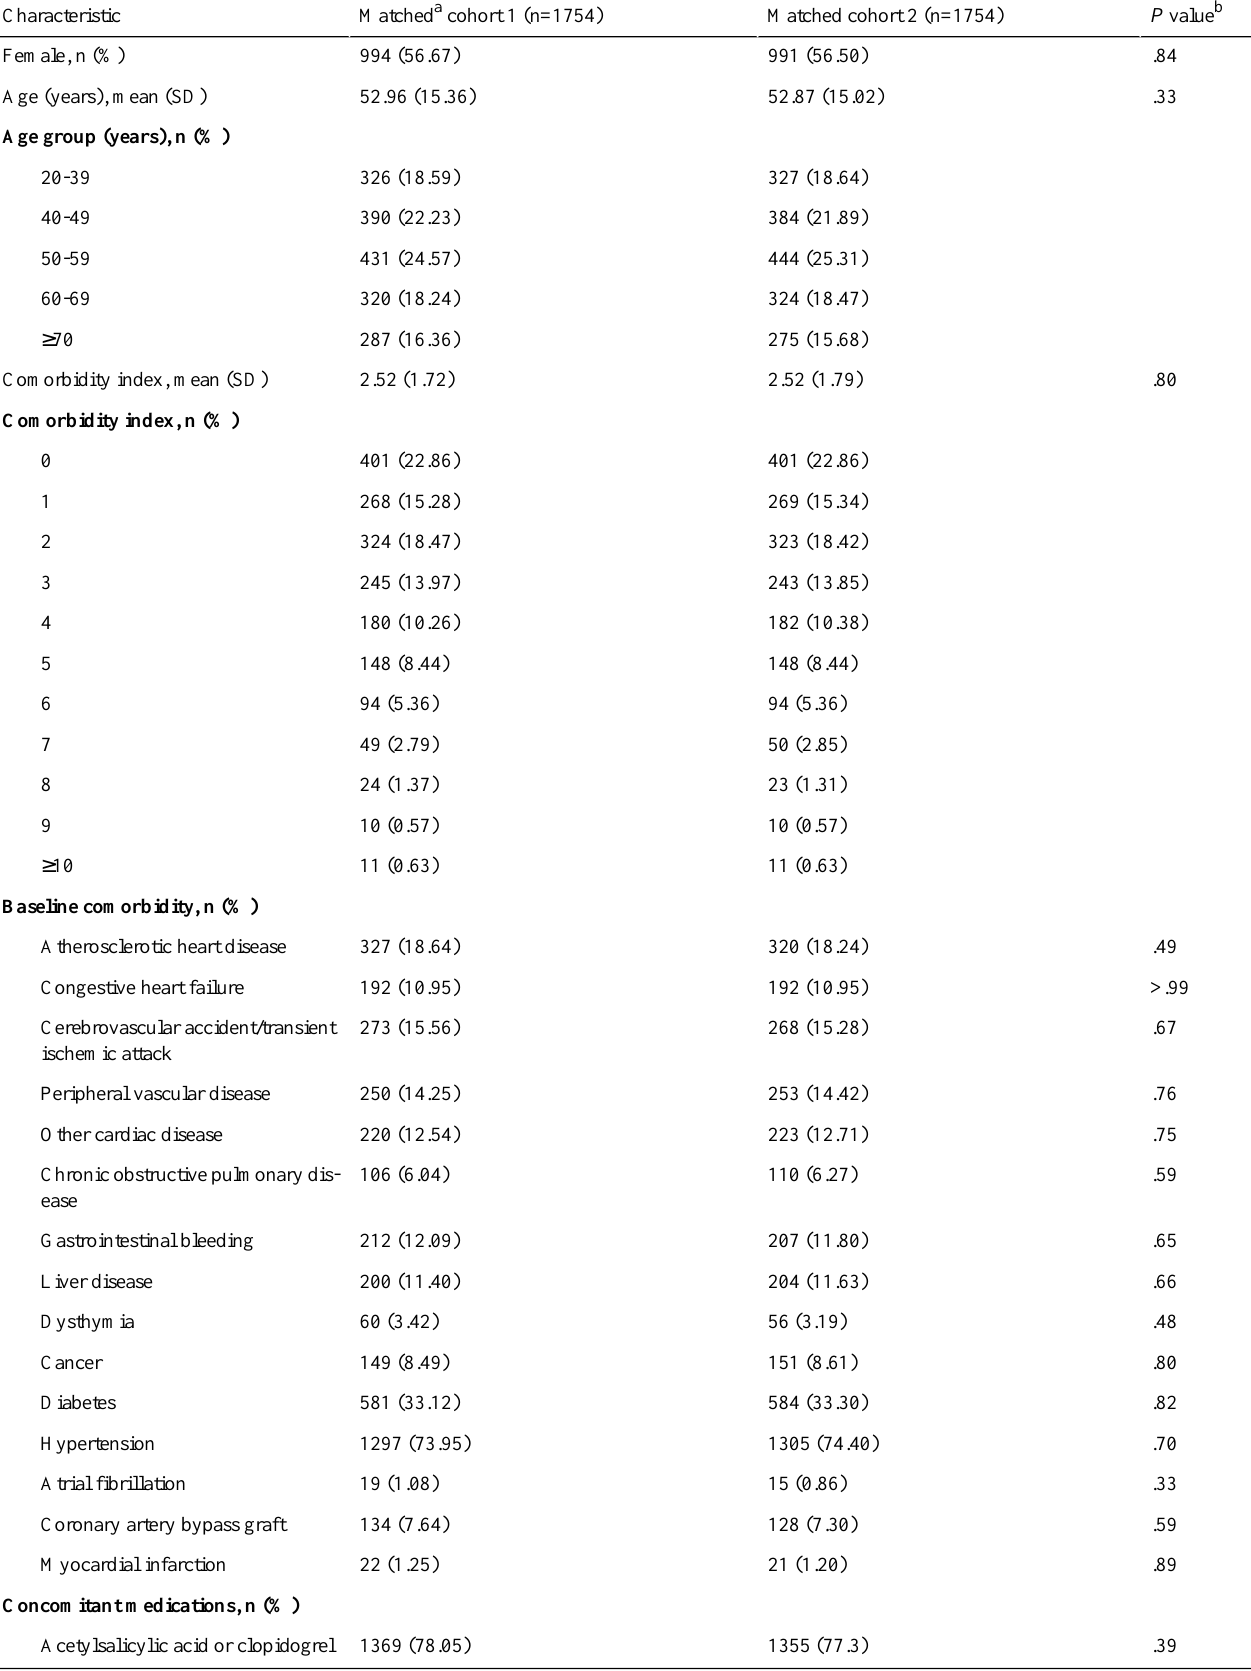
Table 1. Baseline demographics and concomitant medications during the follow-up period in cohort 1 and cohort 2 after matching with the propensity